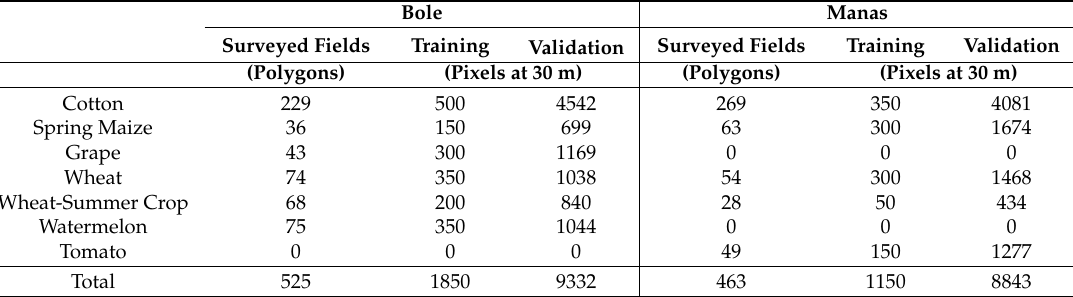
Table 5. The number of training and validation samples in